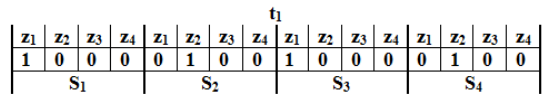
Table 3. Parameters of mobile sensor nodes.